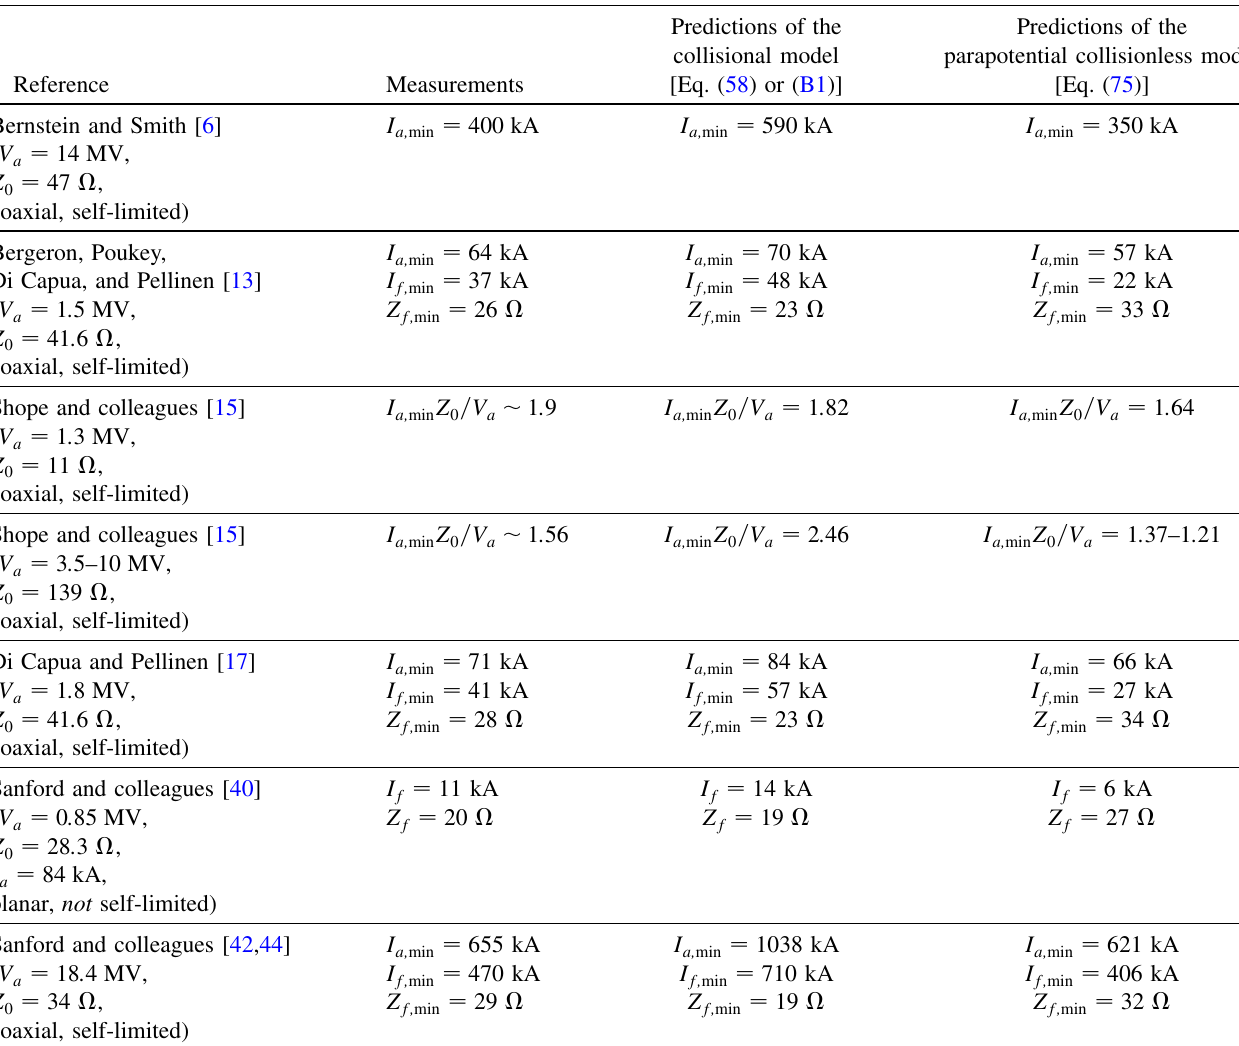
TABLE II. Comparison of measurements with theoretical predictions. The steady-state collisional-MITL model [Eqs. (58) and (B1)] is valid only when the drift of electrons toward the anode has had sufficient time to broaden the electron sheath until a steady-state configuration has been achieved. The parapotential collisionless model [Eq. (75)], developed by Creedon [8,9], is valid in the opposite limit; i.e., when collisional broadening of the sheath can be neglected. We expect experimentally observed MITL parameters to fall between the values predicted in these two limits. For the planar-MITL experiment listed in the first column, we present in the third column the predictions of Eq. (58). For the coaxial-MITL experiments, we present the predictions of Eq. (B1). We note that all the discrepancies in this table between the measurements and collisionless predictions can be accounted for by experimental uncertainties. However, all the discrepancies are in a direction that would be consistent with the existence of